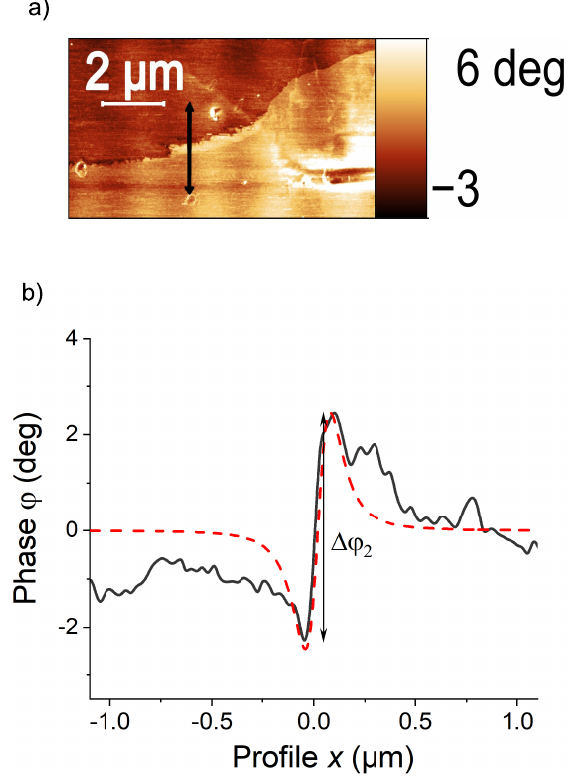
Figure 3. ( a ) MFM image of a sample region with the trapped flux. The current path shows a typical meander-like shape [24,54]. ( b ) Scan line (black) and MFM model (red dash line) using the point monopole tip approximation, see Equation (4). The vertical arrow indicates the definition of phase difference ∆ ϕ 2